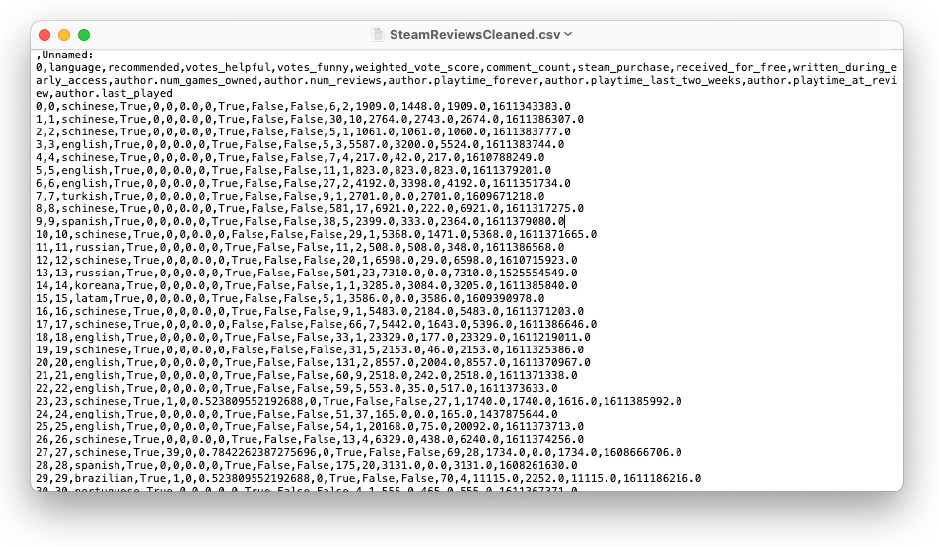
Figure 10. A preview of the ‘SteamReviewsCleaned.csv’